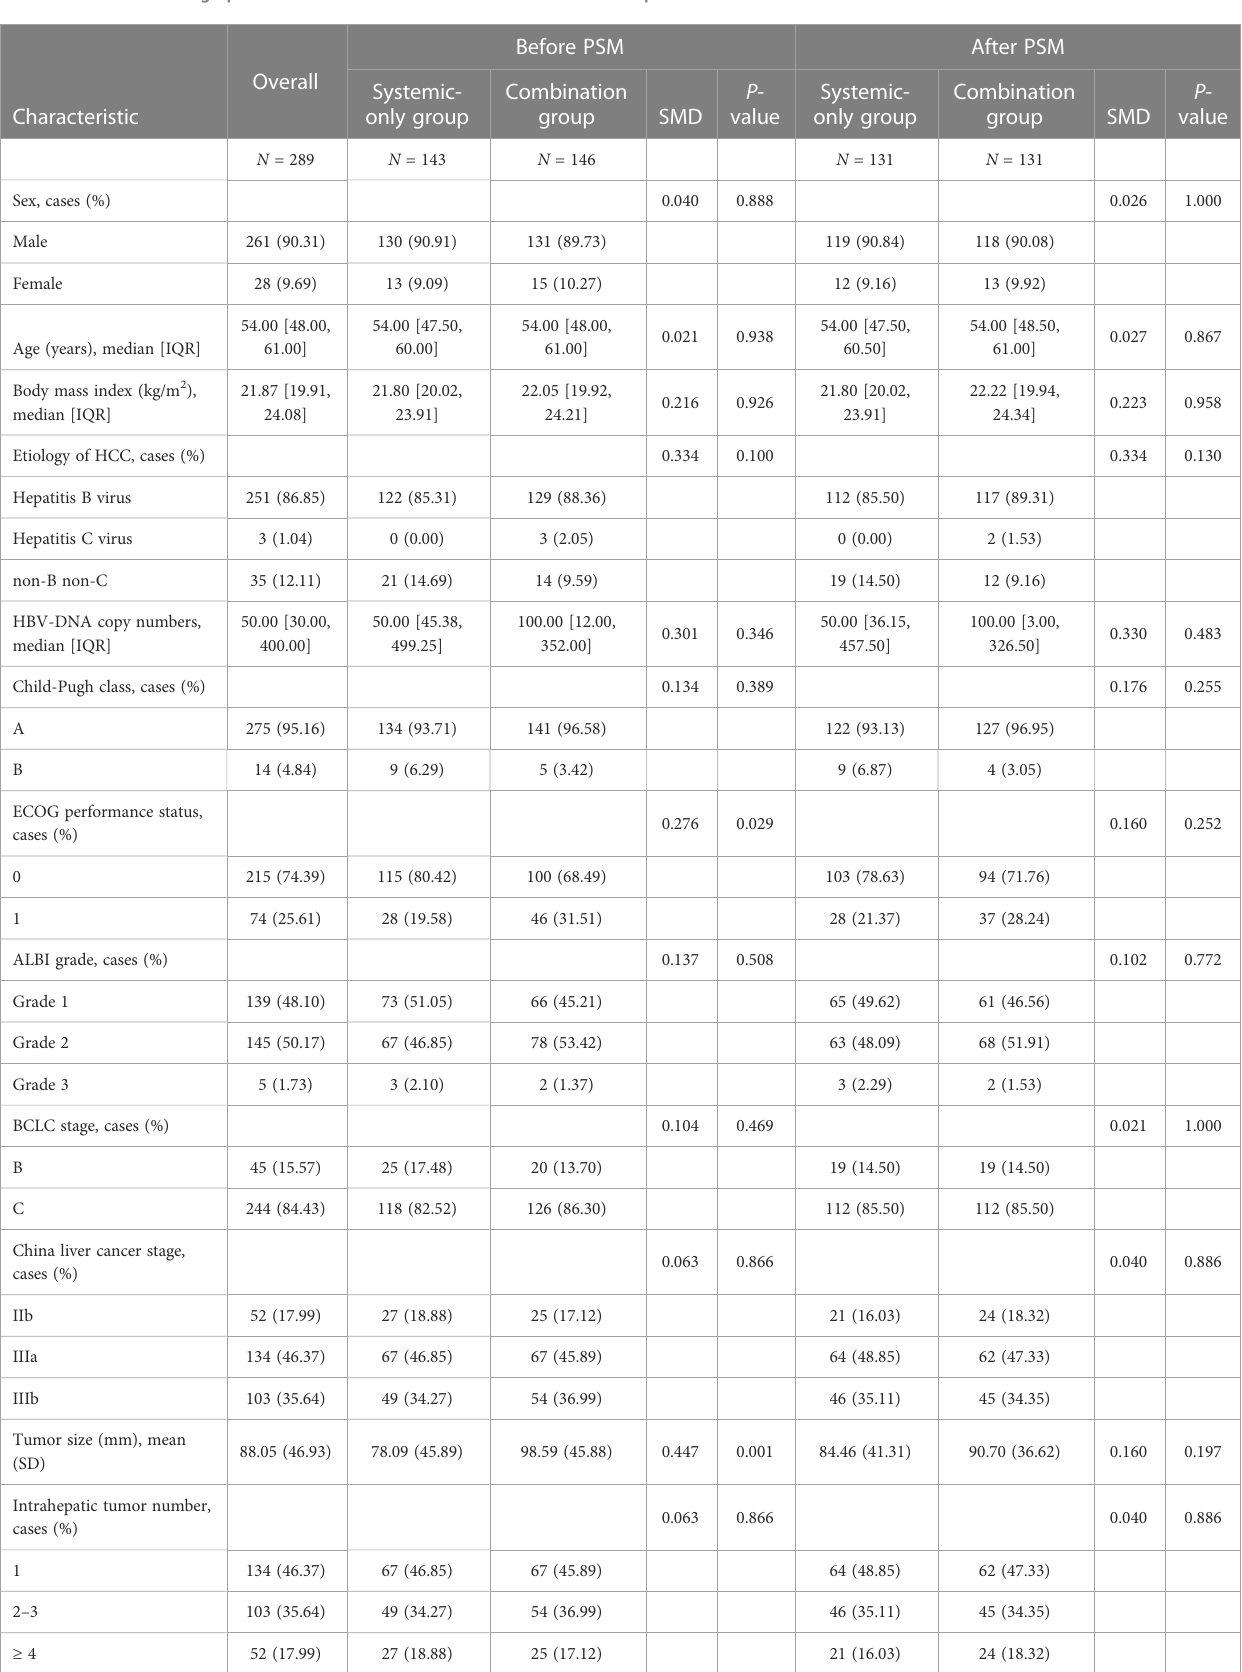
TABLE 1 Baseline demographics and disease characteristics and outcomes of patients before and after PSM. Characteristic